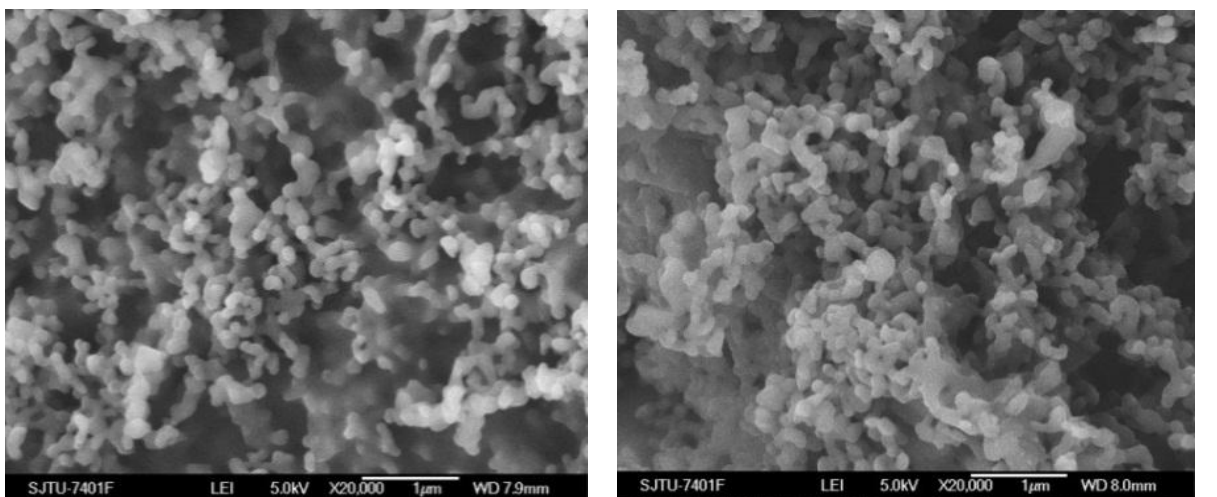
Figure 4. SEM images of nanoparticles prepared by SEDS process with different 5-ASA